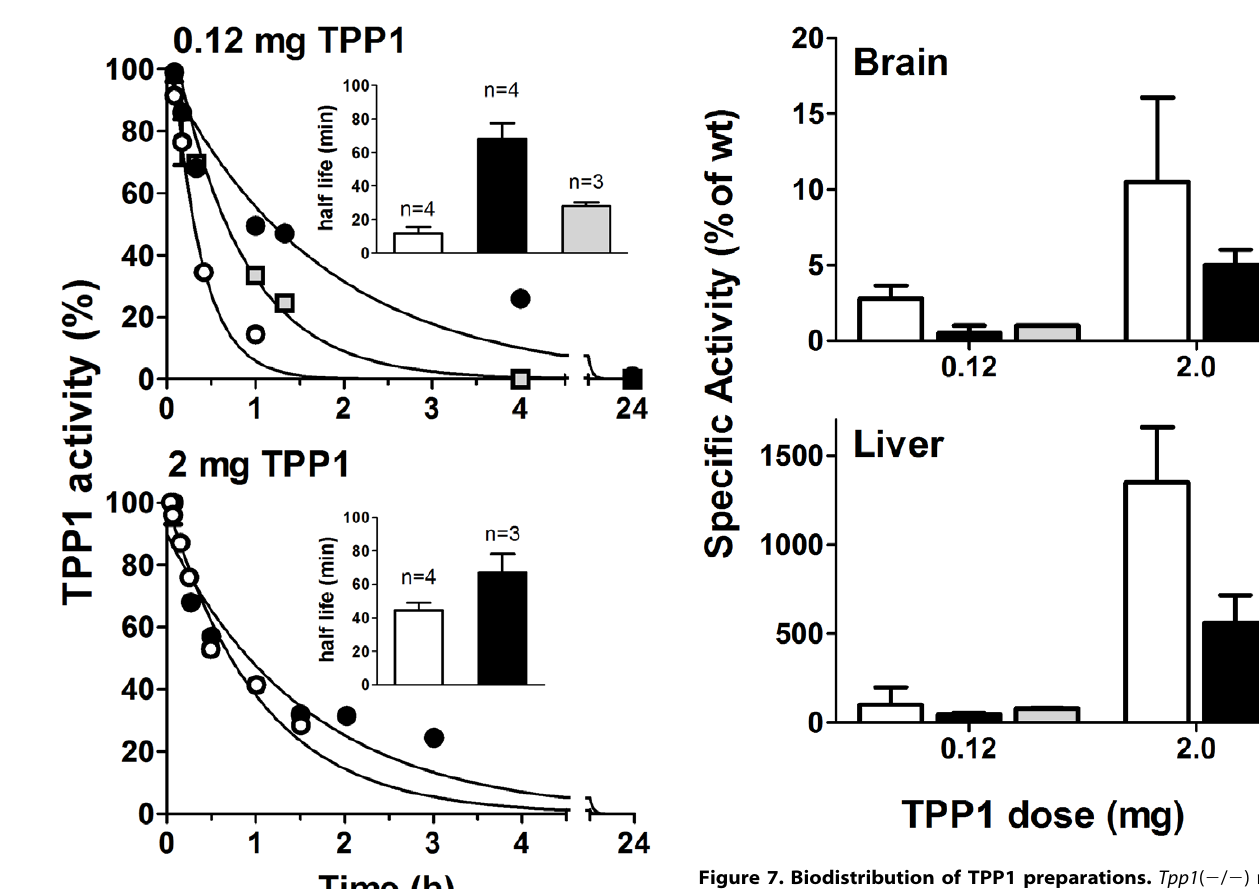
Figure 7. Biodistribution of TPP1 preparations. Tpp1 ( 2 / 2 ) mice were administered indicated amounts of enzyme via tail vein injection and tissues collected after 24 hours. TPP1 specific activity (activity/mg protein) was normalized to that of wild-type controls. Unmodified TPP1, open bars; OX-TPP1, filled bars, DG-TPP1, gray bars. Sample size as in Table 1. Error bars represent standard